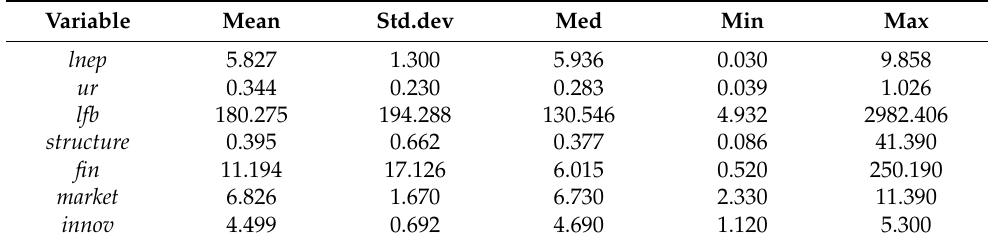
Table 1. Descriptive statistics of main variables.